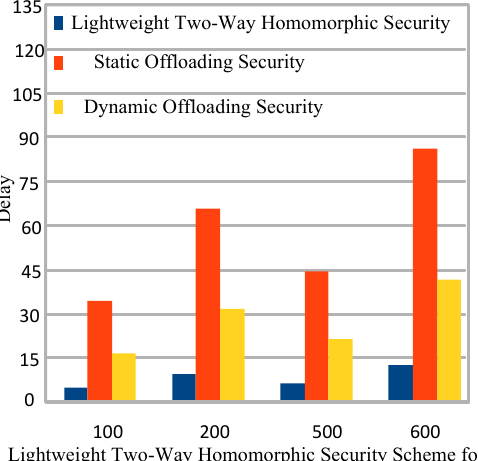
Figure 6. Lightweight Secure Offloading of Workflow Applications.